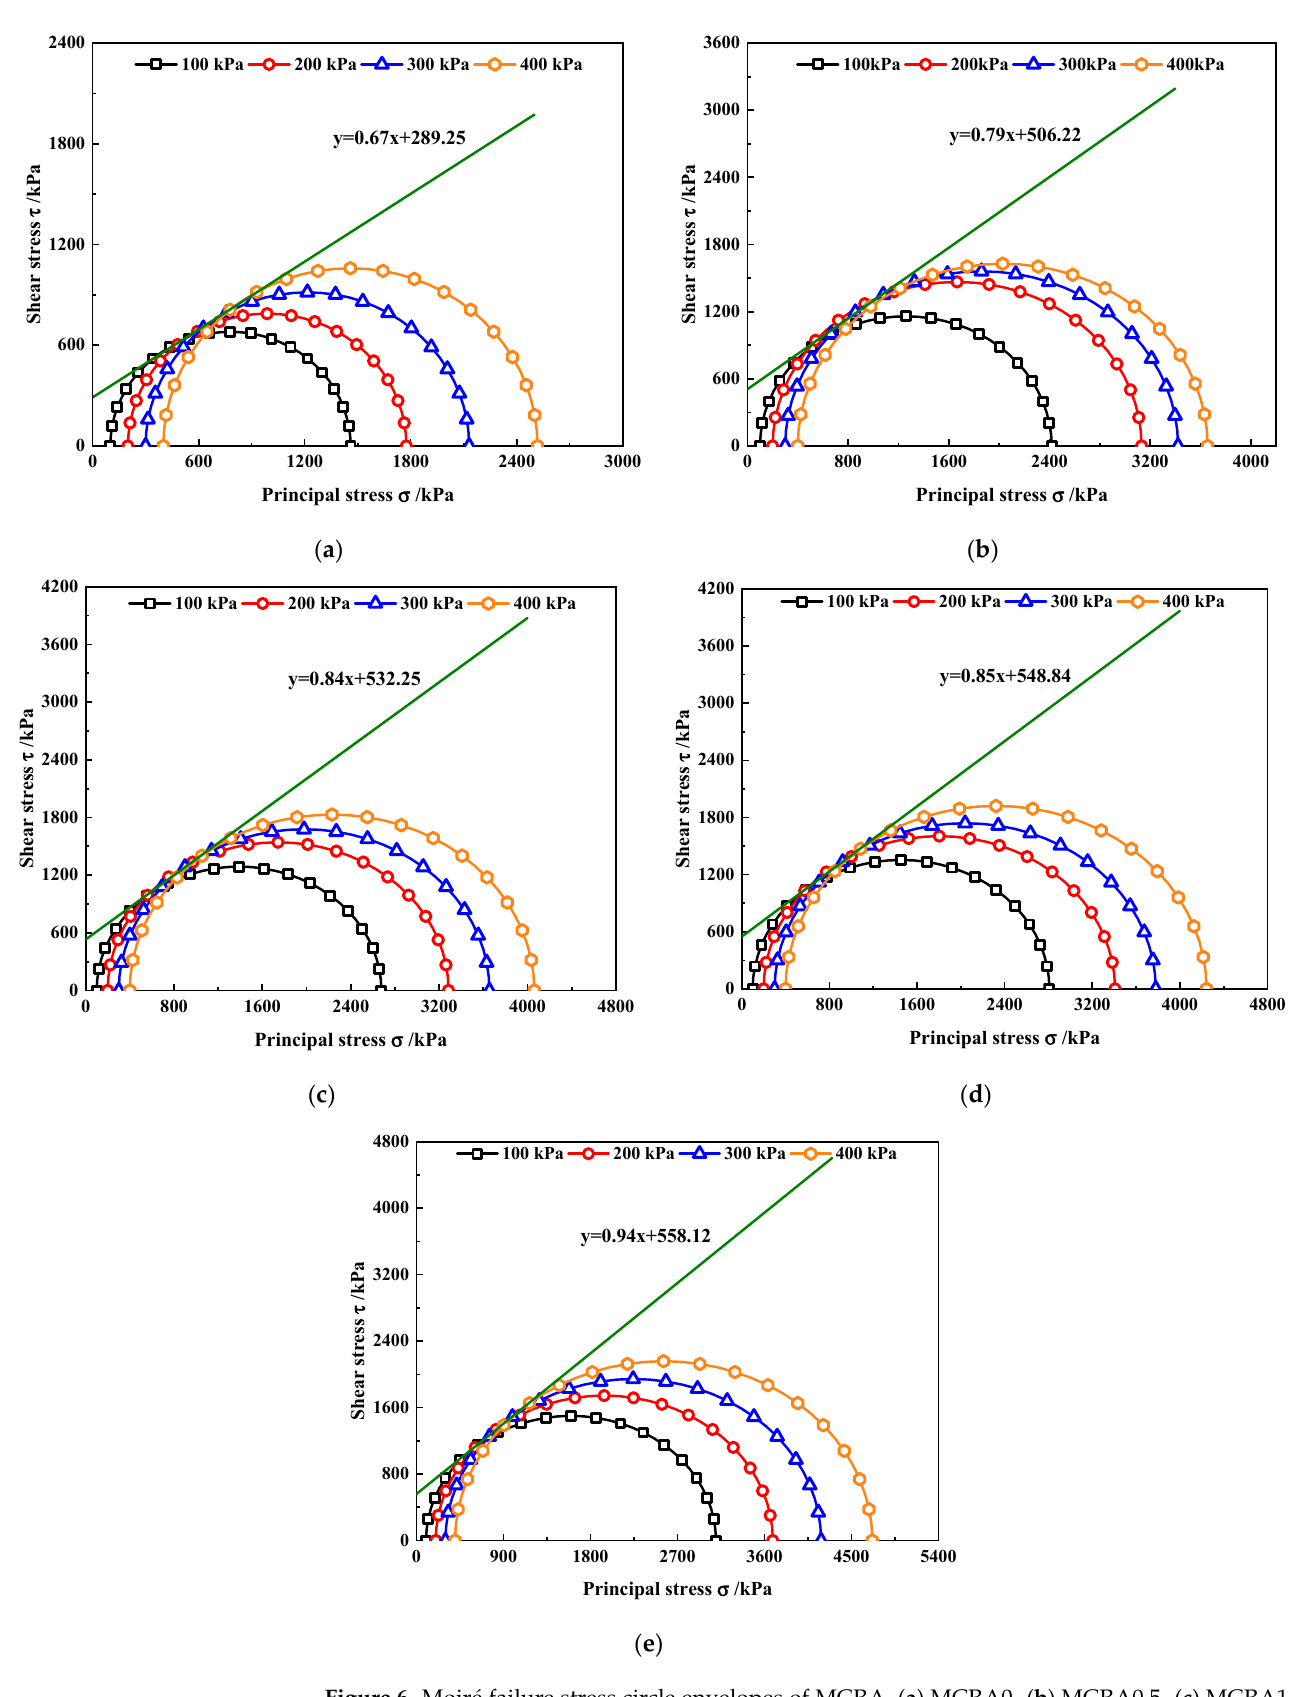
Figure 6. Moiré failure stress circle envelopes of MCRA. ( a ) MCRA0. ( b ) MCRA0.5. ( c ) MCRA1.0. ( d ) MCRA1.5. ( e ) MCRA2.0. Table 6. Shear strength parameters of MCRA.